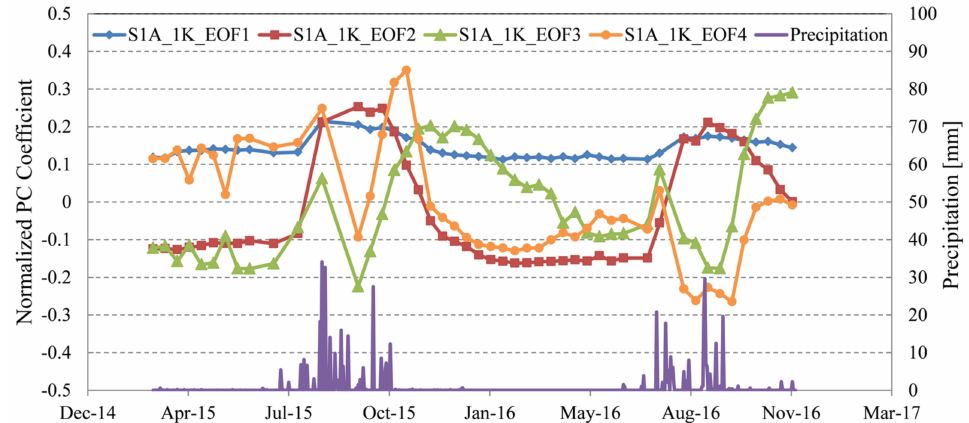
Figure 6. The temporal evolution of corresponding principal components (PCs) for EOFs of S1A_1K.